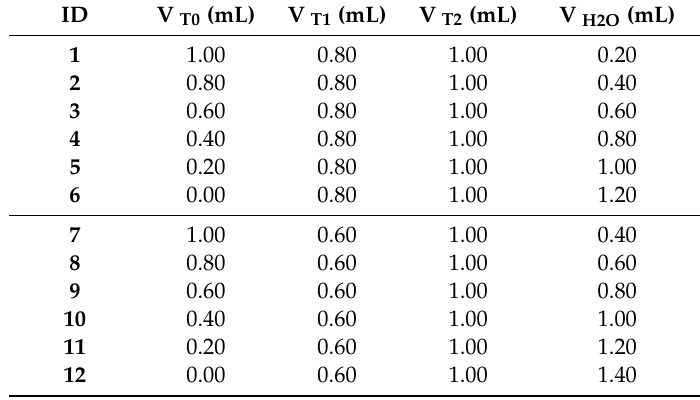
Table 2. Crossed interference matrix excerpt, where the concentration of T0 varies coupled to